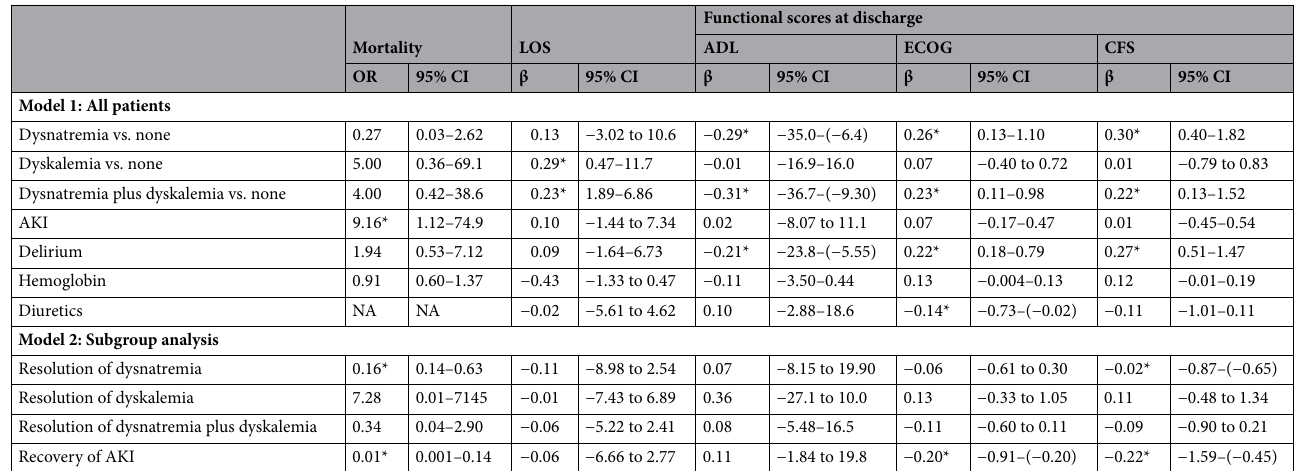
Table 3. Multivariate regression analyses of the effects of electrolyte imbalance and AKI on in-hospital complications and functional status at discharge. Model 1: adjusted for age, gender, BMI, Charlson comorbidity index, hemoglobin, white blood cell, eGFR, sodium, potassium, psychotropic agents, renin angiotensin system inhibitors, diuretics, delirium, AKI, dysnatremia vs. none, dyskalemia vs. none, dysnatremia plus dyskalemia vs. none. Model 2: adjusted for age, gender, BMI, Charlson comorbidity index, hemoglobin, white blood cell, eGFR, dysnatremia, dyskalemia, sodium, potassium, psychotropic agents, renin angiotensin system inhibitors, diuretics, delirium, AKI, resolution of dysnatremia, resolution of dyskalemia, resolution of dysnatremia plus dyskalemia, recovery of AKI. AKI acute kidney injury, ADL activities of daily living, ECOG eastern cooperative oncology group, CFS clinical frailty score, LOS length of stay. * P <